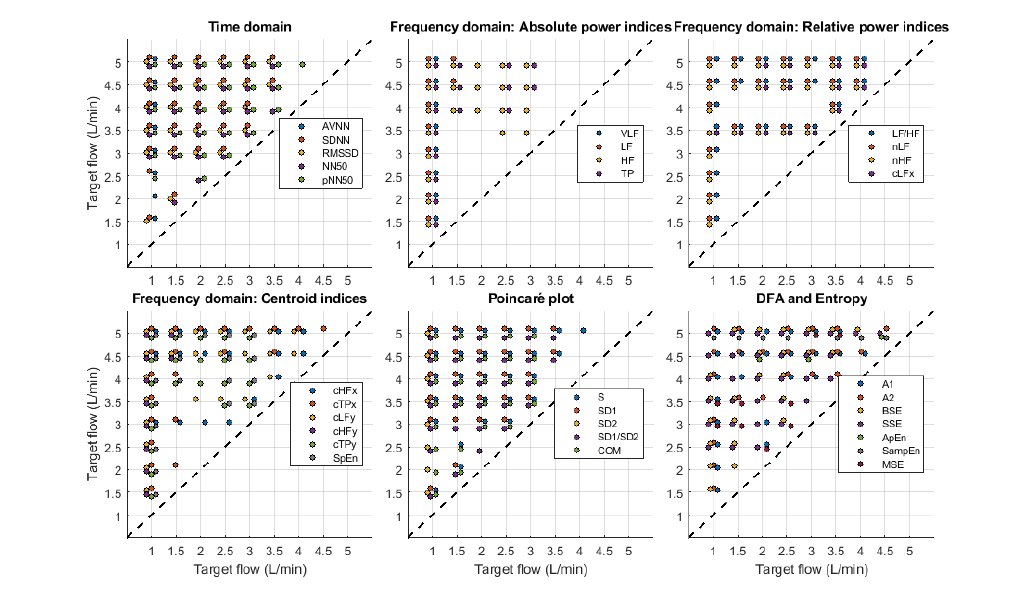
Figure 9. Post-hoc comparisons for target flow (TF) levels when pulse rate variability indices are measured from the radial phantom. The appearance of a circle indicates a significant difference between the corresponding levels for each of the indices.